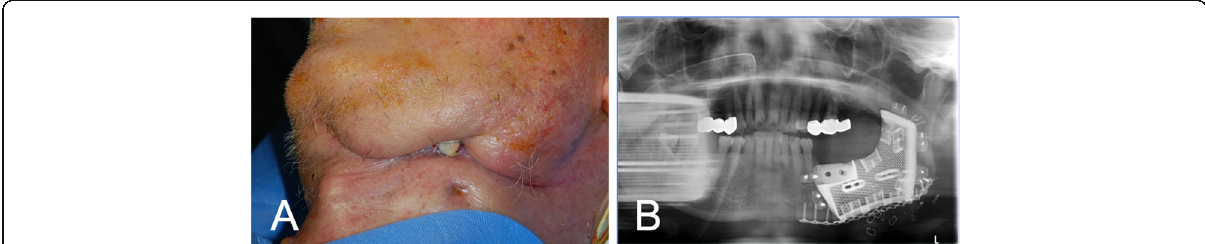
Fig. 1 Failure of reconstruction after wide resection of mandibular composite tissue. a Submandibular fistula formation with chronic purulent discharge. b Setting state of the titanium block in the mandibular